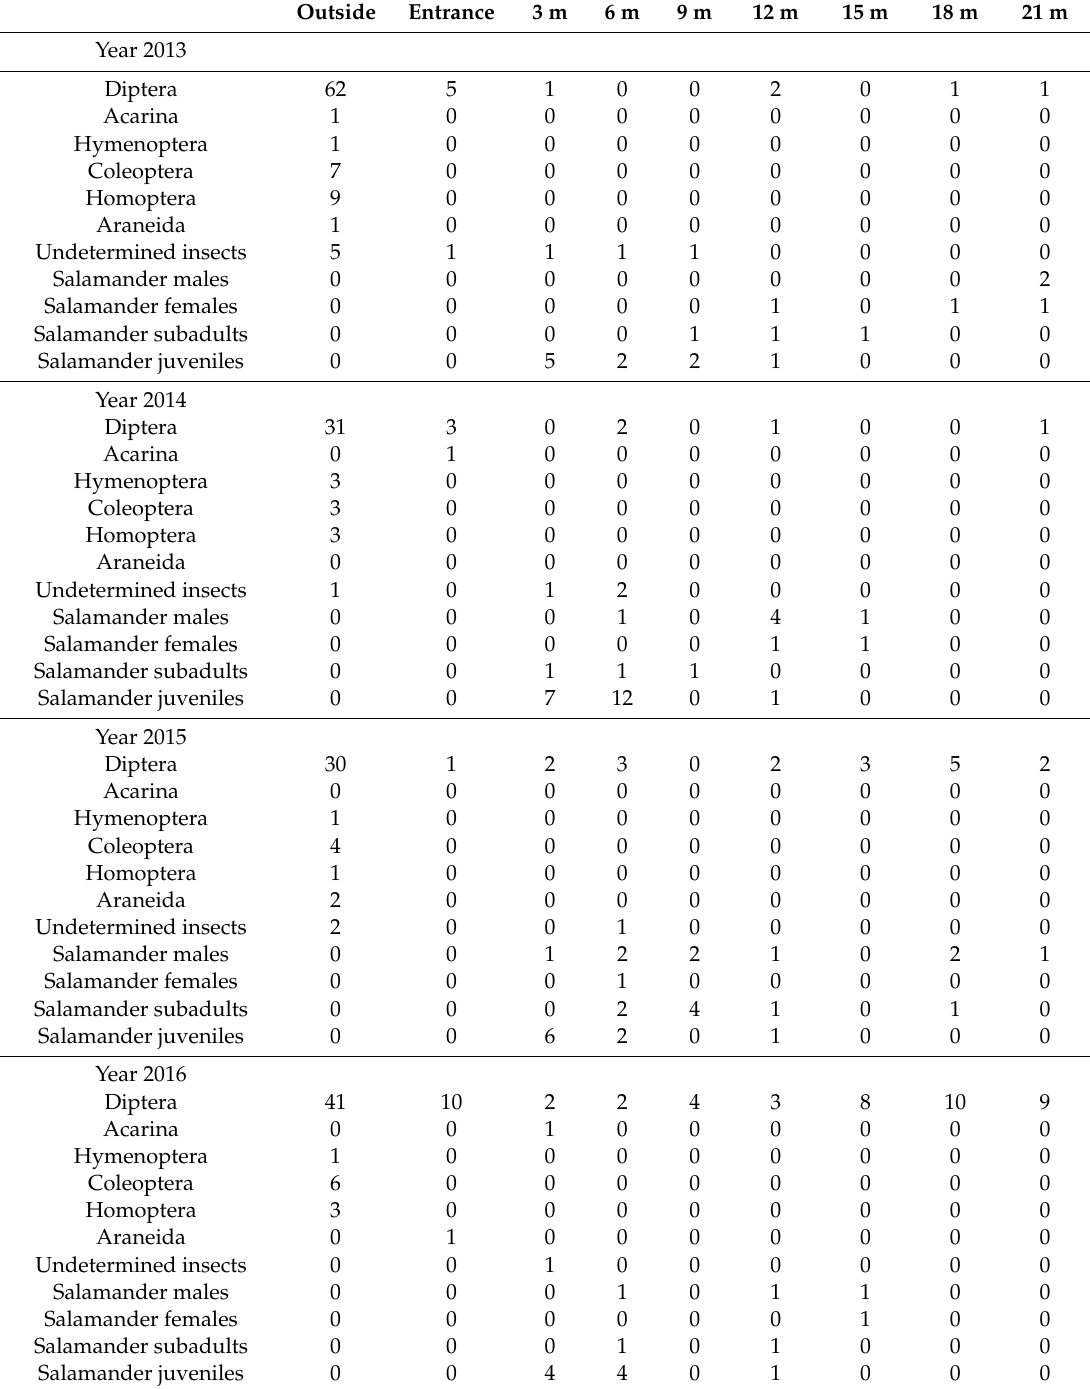
Table 2. Faunal community sampled outside, at the entrance and at di ff erent distances inside the “Biospeleological Station of San Bartolomeo”. The category “Undetermined insects” was not used in multivariate